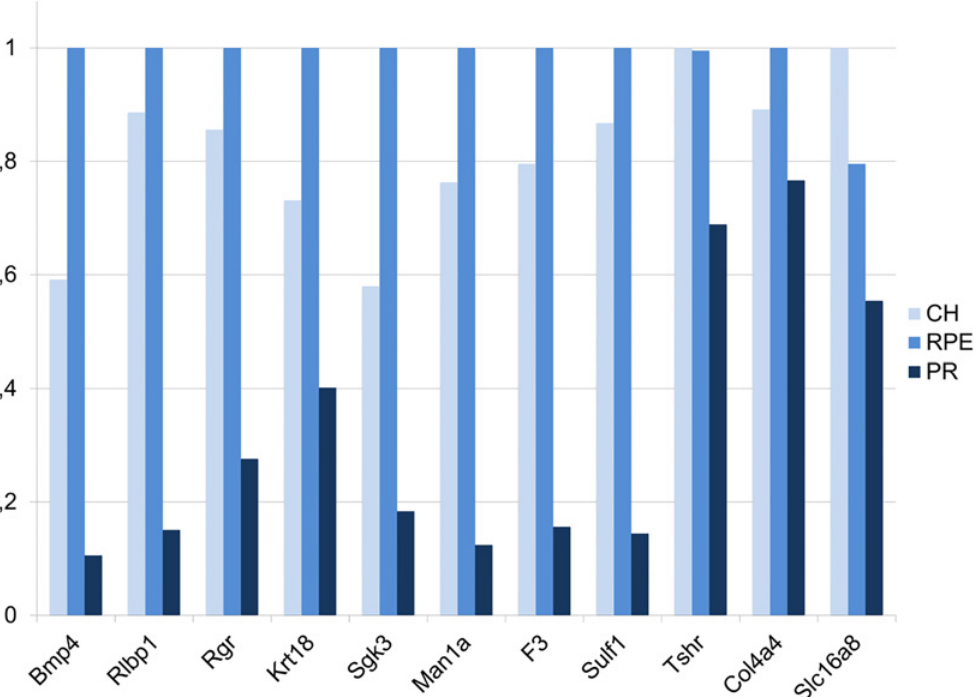
Fig 1. Confirmation of microarray results by sqRT-PCR. Beta-actin ( Bact ), a housekeeping gene, was used to normalize gene expression in mouse CH, RPE and PR. The light blue bars indicate expression levels in CH, the blue bars expression levels in the RPE and the dark blue bars indicate expression levels in PR. Similar to the microarray data the expression level is highest in the RPE and lowest in the PR. The sqRT-PCR results confirm our findings; however Tshr and Slc16a8 show expression lower in RPE compared to choroid. Overall, the sqRT-PCR confirmation rate in this, and in all our previous studies (combined), using exactly the same methodology and platform to investigate neuroepithelia from human donor eyes and brains was 87% [12 – 14].